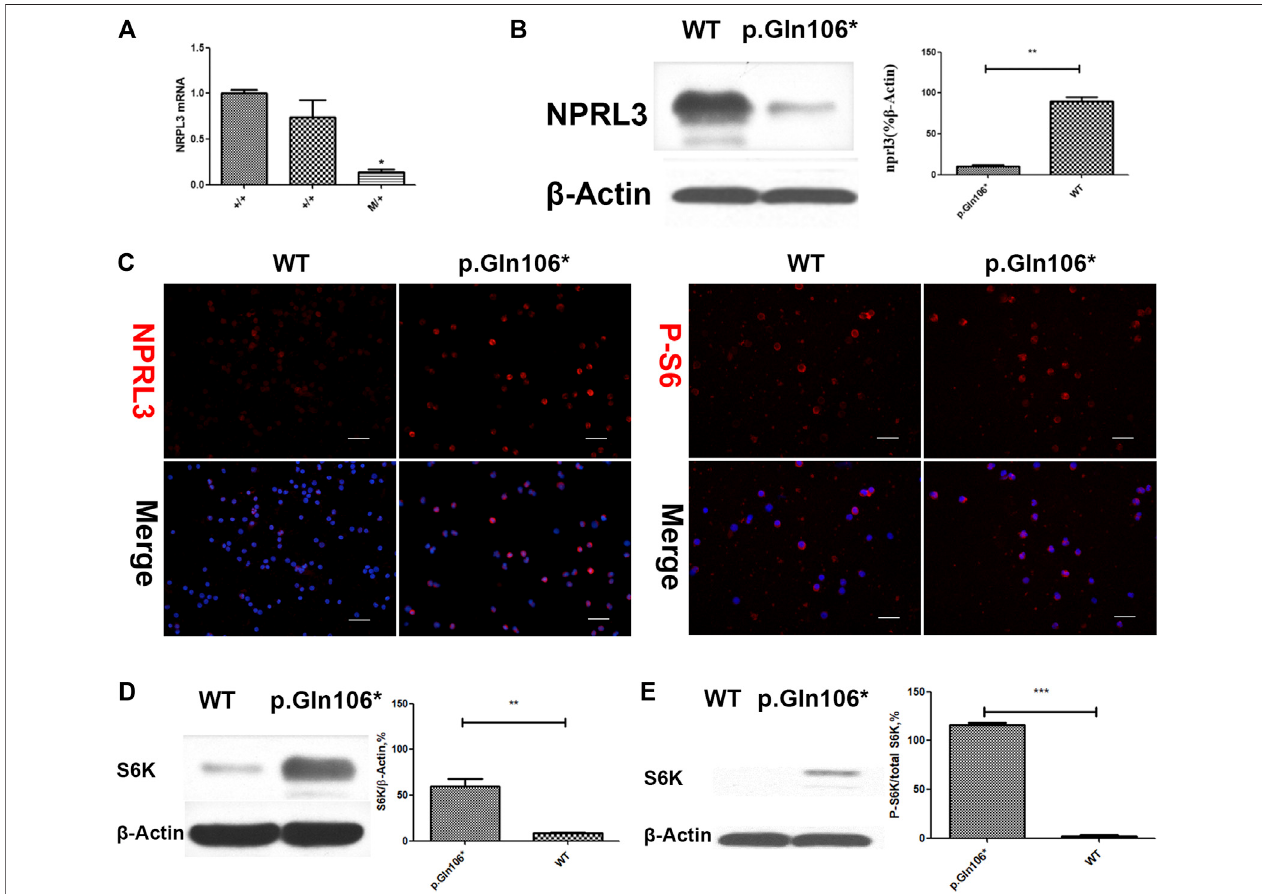
FIGURE3| Analysisofsteady-statemRNAlevels inperipheralbloodcellsfromindividualswithmutationsinNPRL3predicted toresultinhaploinsuf fi ciency.Group p. Gln106* included IV-3, V-13, and V-1 carrying NPRL3 gene mutation (c.316C > T, p . Gln106*) and group WT included three healthy family membersV-2, V-22, and V- 26. (A) Real-time (RT) quantitative polymerase chain reaction (PCR) analysis of wild-type (+/+) and mutation carrier (m/+) RNA was performed, and the transcription of NPRL3 was signi fi cantly reduced in the group of mutation carriers (* p < 0.05). The experiment was repeated at least three times and produced consistent results. (B – E) Western blot and immunobiology showed the expression of NPRL3 was decreased and the expression of PS6 was increased in peripheral blood lymphocytes of patients with P.Gln106 * mutation 。